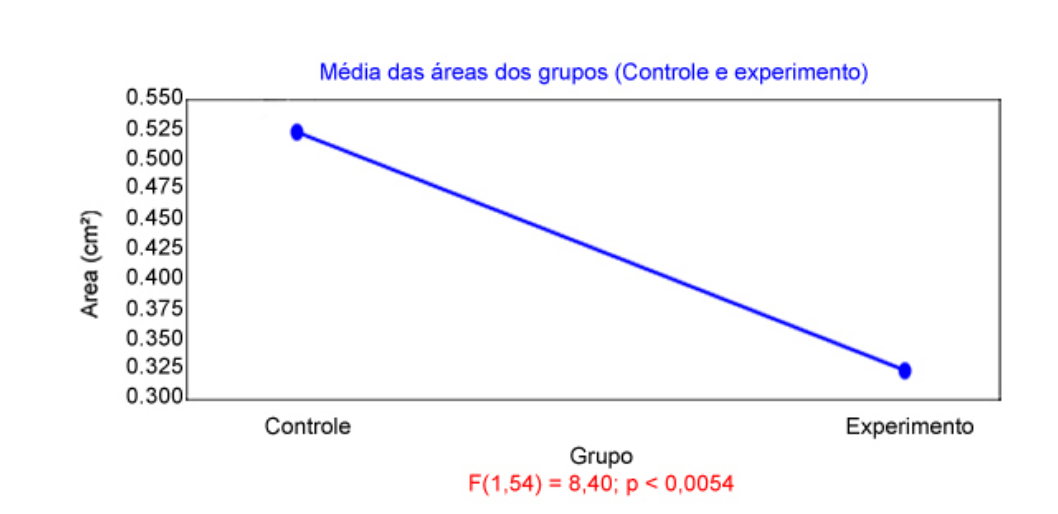
FIGURA 7 - Média das áreas dos grupos (Controle e Experimento). Legenda : F= Significância da Interação, p= Nível de